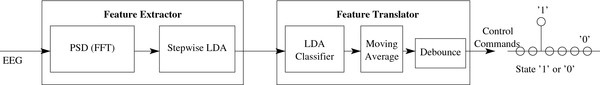
Structure of the Feature Extraction and Classification Blocks of the BCI. The structure of the feature extraction and classification algorithms of the self-paced BCI system
[7].